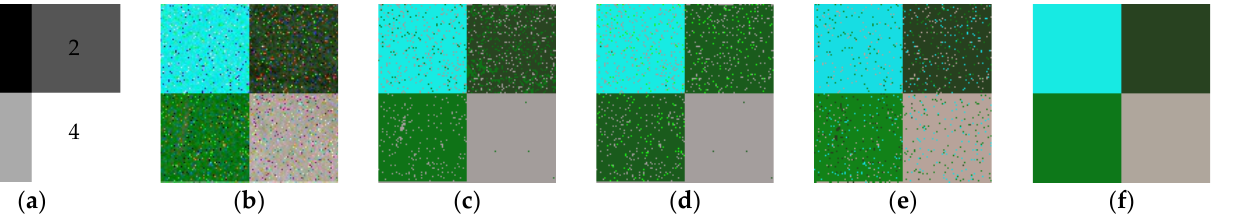
Figure 6. The segmentation experiment of the multispectral synthetic image. ( a ) the template image, and 1 – 4 are the labels of regions, ( b ) the noise multispectral synthetic image, ( c ) FCM algorithm, ( d ) GMM algorithm, ( e ) SMM algorithm, ( f ) HSMM algorithm.